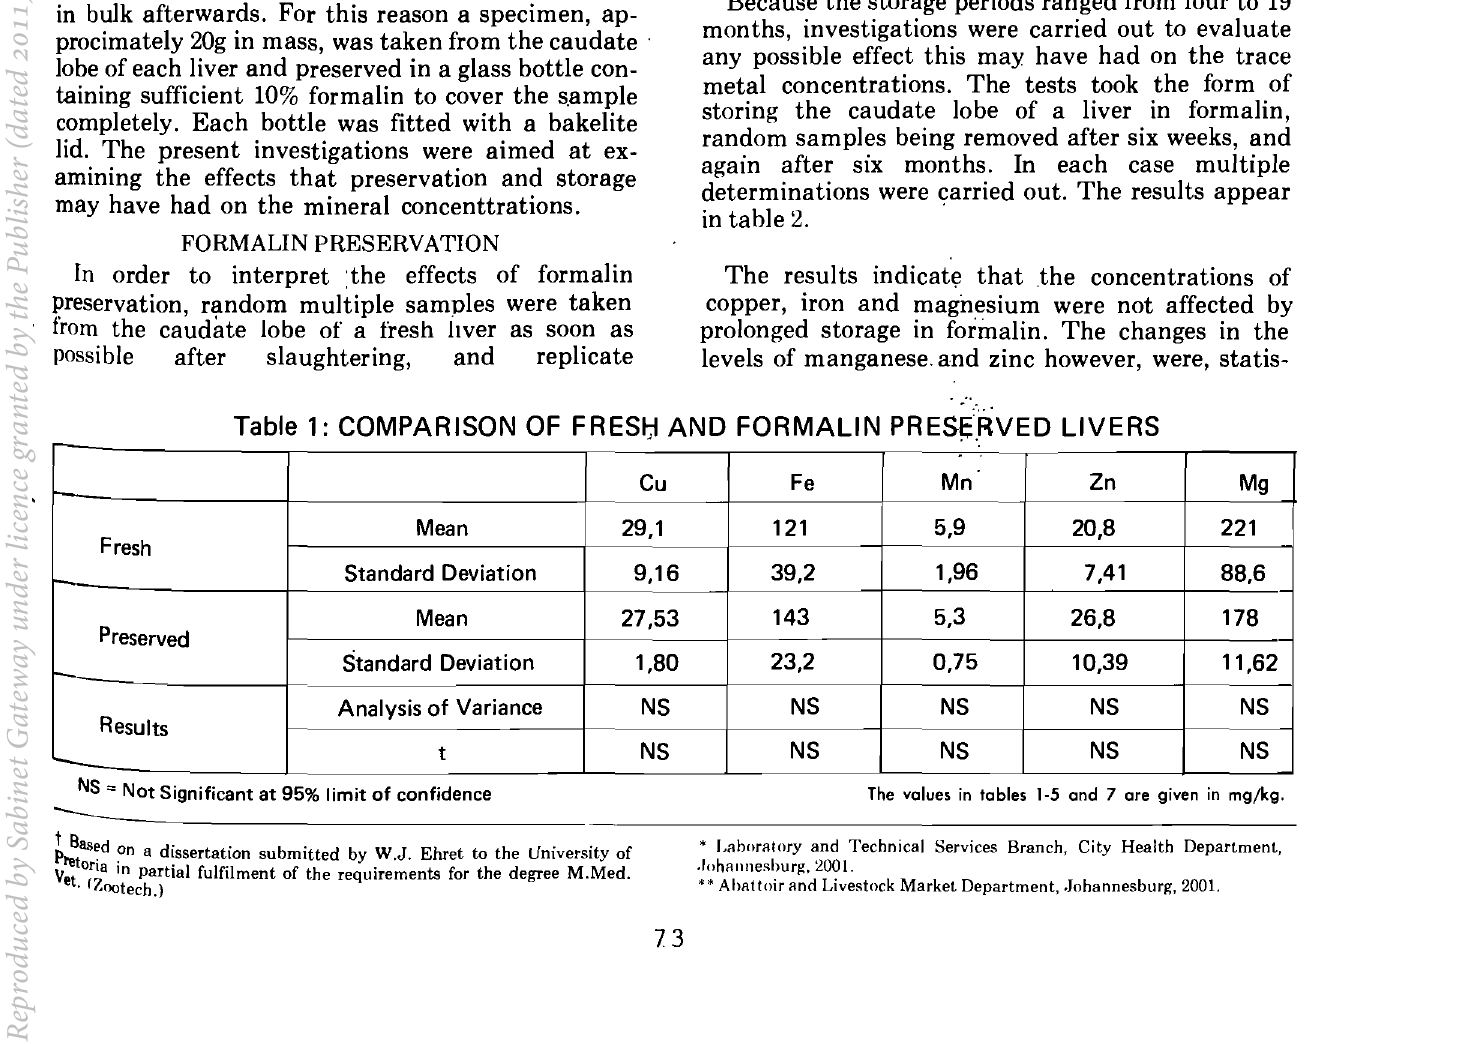
Table 1: COMPARISON OF FREStl AND FORMALIN PRESi;.RVED LIVERS